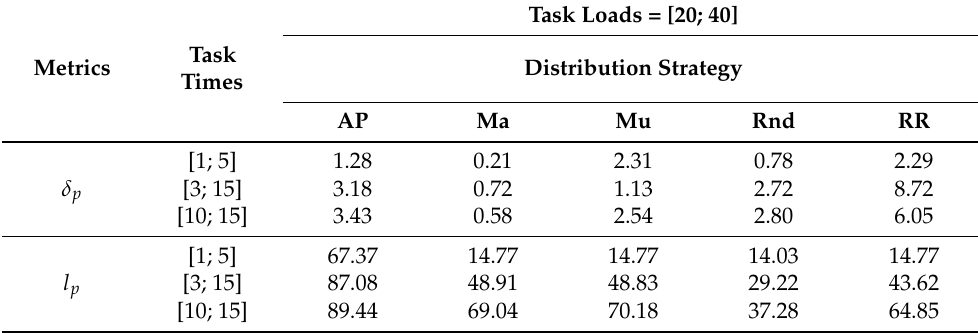
Table 5. Statistics for tasks with a high amount of required processing power and various required